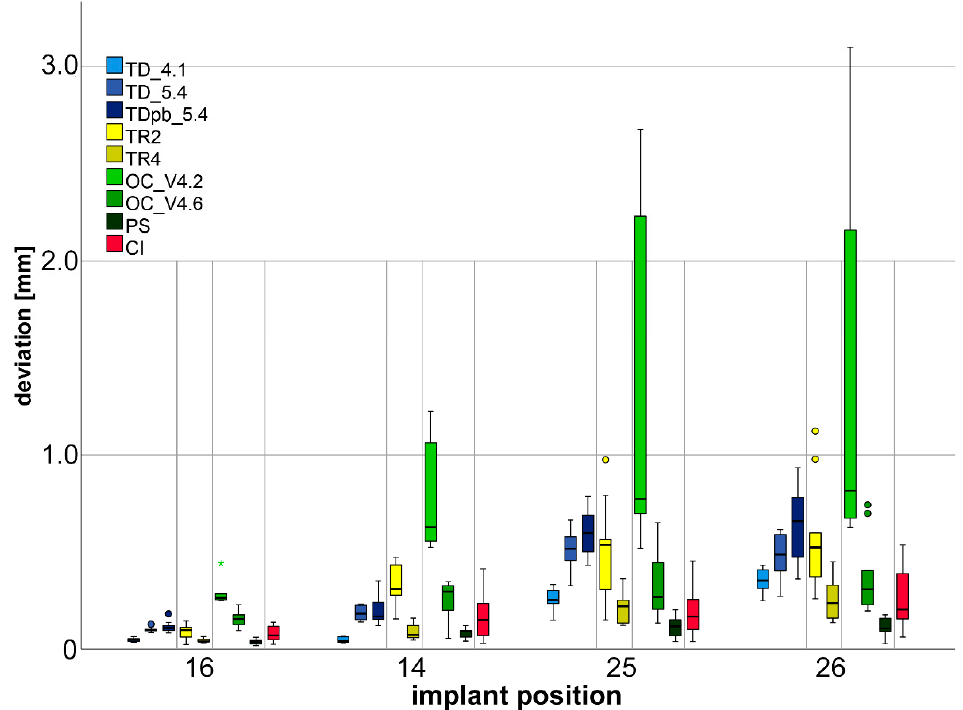
Figure 3. Results for the absolute three-dimensional deviations for the implant positions for each intraoral scanner